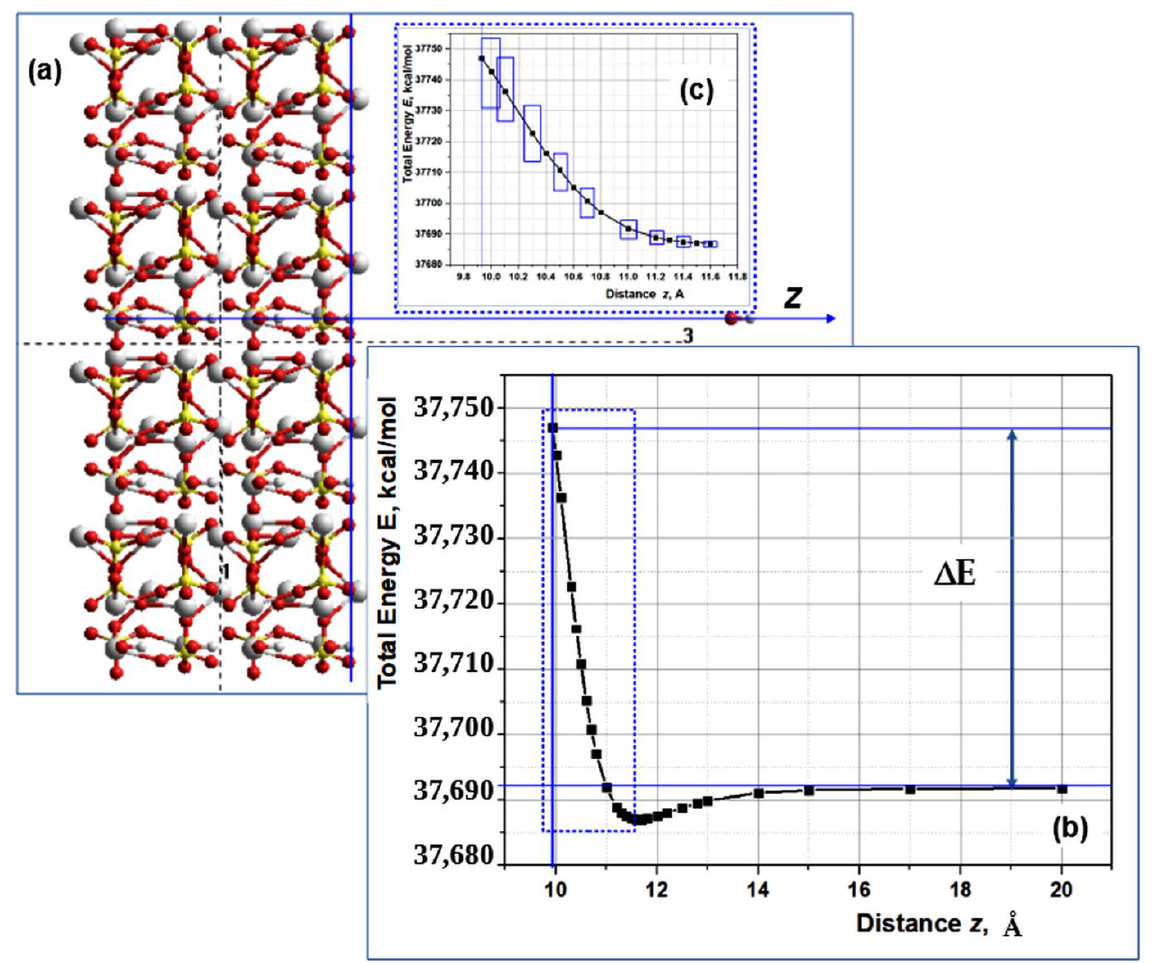
Figure 8. Model of OH going out from HAP32 and change of the system total energy: ( a ) the distance z is along c -axis of the HAP32 cluster model, which is shown as axis number 3 (it is perpendicular to the surface plane of the HAP32 cluster); axis number 1 is along a -axis of the HAP32 model; axis number 2 is along b -axis of the HAP32 cluster (it is perpendicular to the image plane); ( b ) the graph shows the profile of the change in the total energy of the systems as the OH ion moves away from the surface of the HAP32 cluster (an example of one typical calculation); ( c ) the inset shows the selected part (outlined by a blue rectangle with a short dashed line).